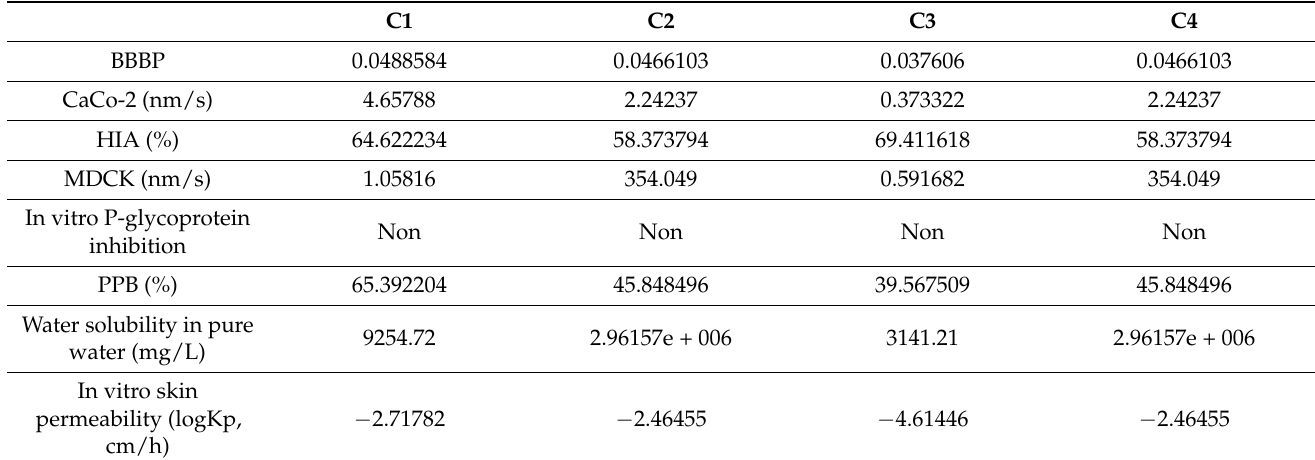
Table 5. PreADMET results characteristics for potential SaSK